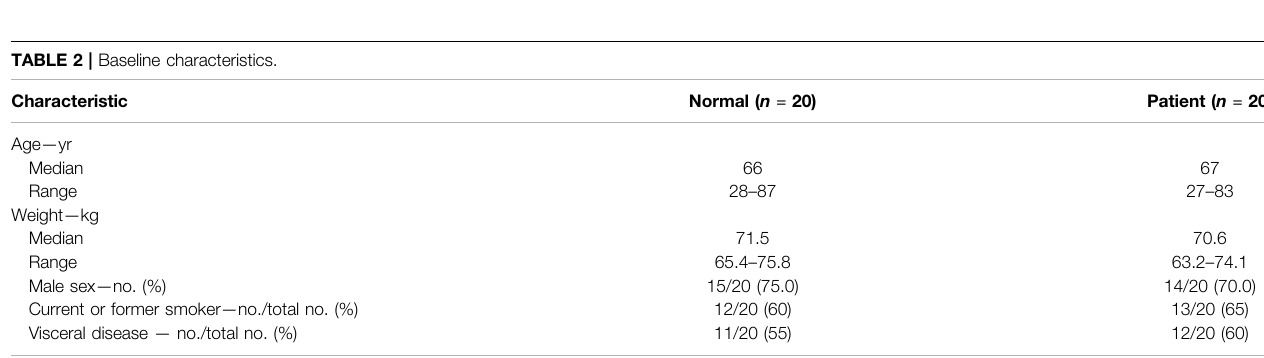
TABLE 2 | Baseline